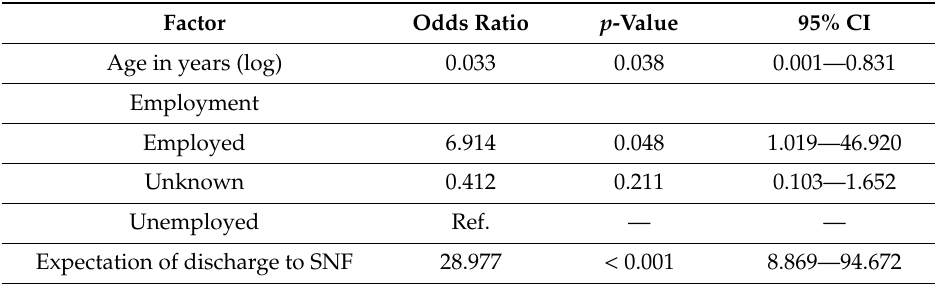
Table 2. Multiple logistic regression model predicting discharge to home after